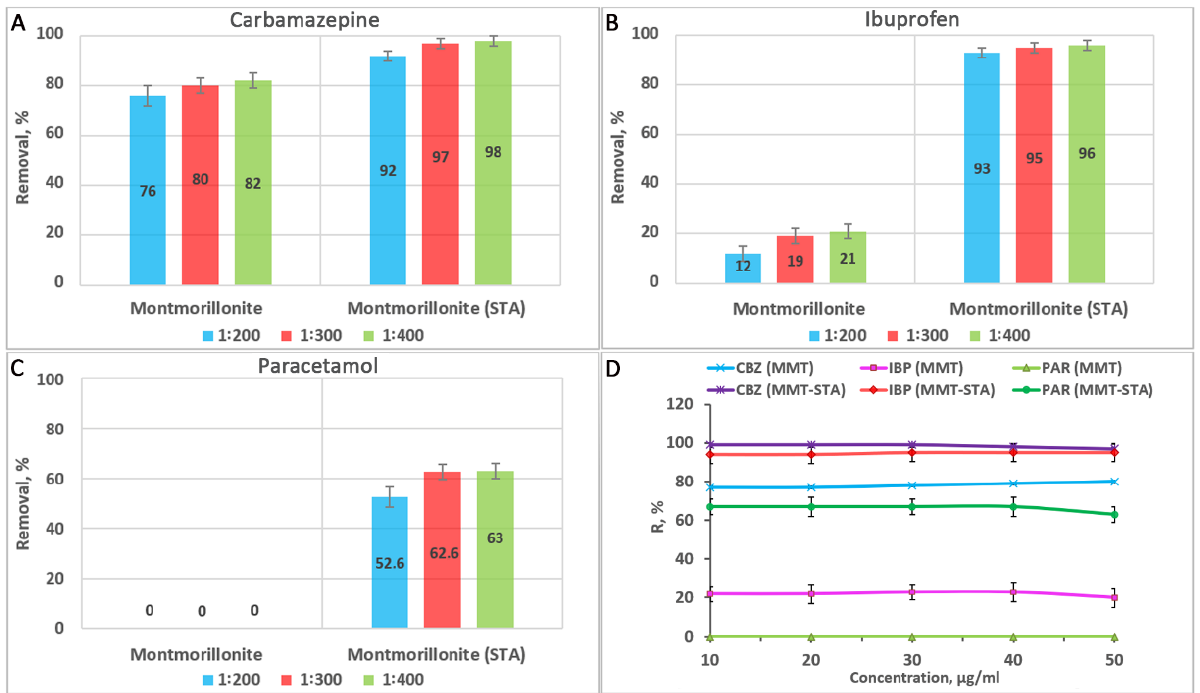
Figure 8. Dependence of the PP removal efficiency on the mass of adsorbents ( A – C ) and on the concentration of PP at the mass ratio of clay adsorbent to adsorbate of 300:1 ( D ).